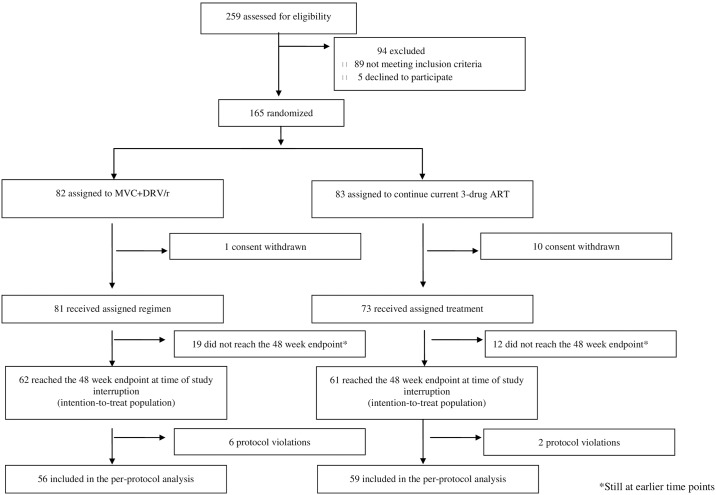
GUSTA flow diagram.